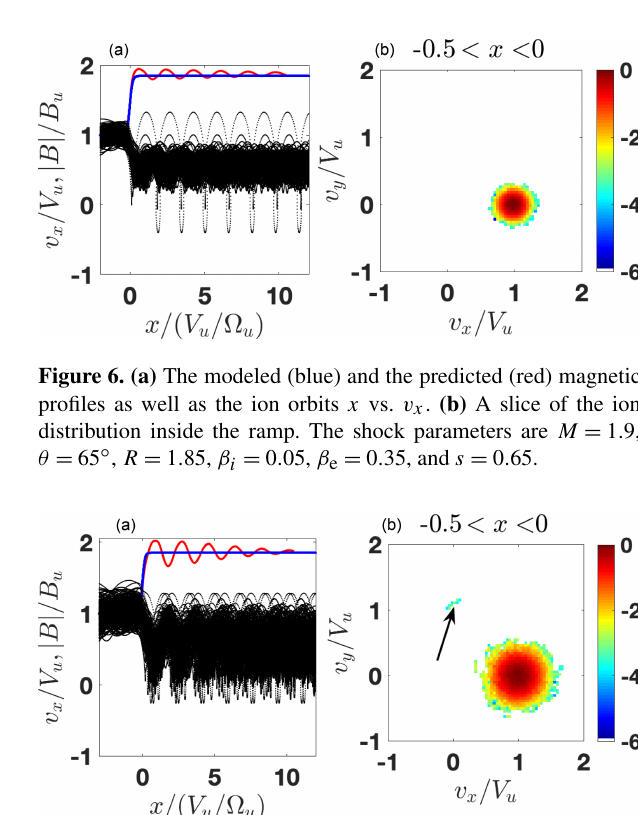
Figure 7. (a) The modeled (blue) and the predicted (red) magnetic profiles as well as the ion orbits x vs. v x . (b) A slice of the ion distribution inside the ramp. The shock parameters are M = 2 . 05, θ = 65 ◦ , R = 1 . 85, β i = 0 . 2, β e = 0 . 35, and s = 0 . 4. The arrow points to the (quasi-)reflected